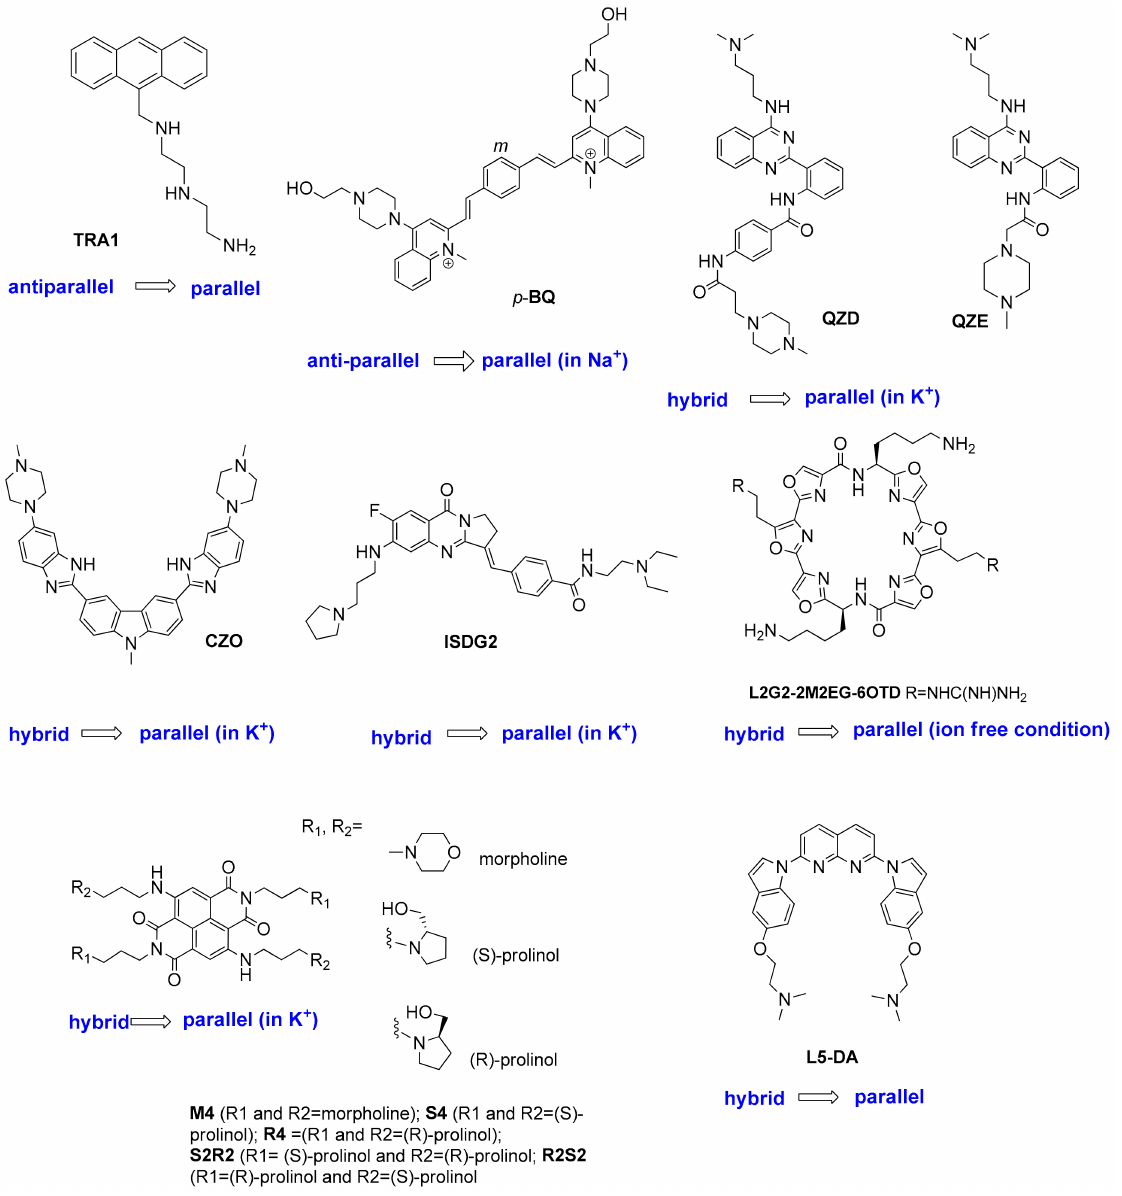
Figure 21. G4 ligands able to induce a topological switch to parallel. Nagasawa and co-workers, inspired by the natural G4 ligand telomestatin , synthe- sized a series of macrocyclic hexaoxazoles as G4 ligands. In previous studies, they reported that the ligand 3,3-L2H2-6OTD (Figure 15) bearing two n-butyl amino side chains, shows potent G4-stabilizing activity and induces the anti-parallel topology of the telomeric